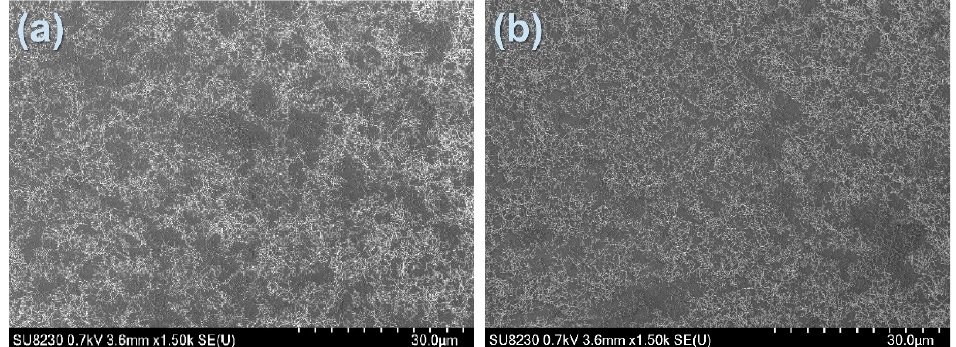
Figure 2. FE-SEM micrographs of deposited SWCNTs atop cleaned and APTES-silanized SiO 2 surfaces that are ( a ) 90 nm thick and ( b ) 300 nm thick.